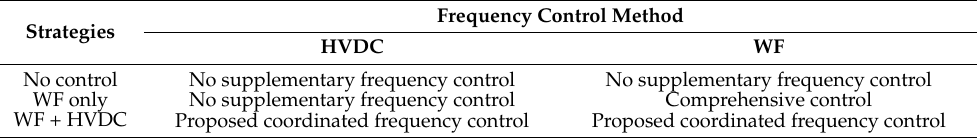
Table 4. Frequency control methods of HVDC and WF in different control